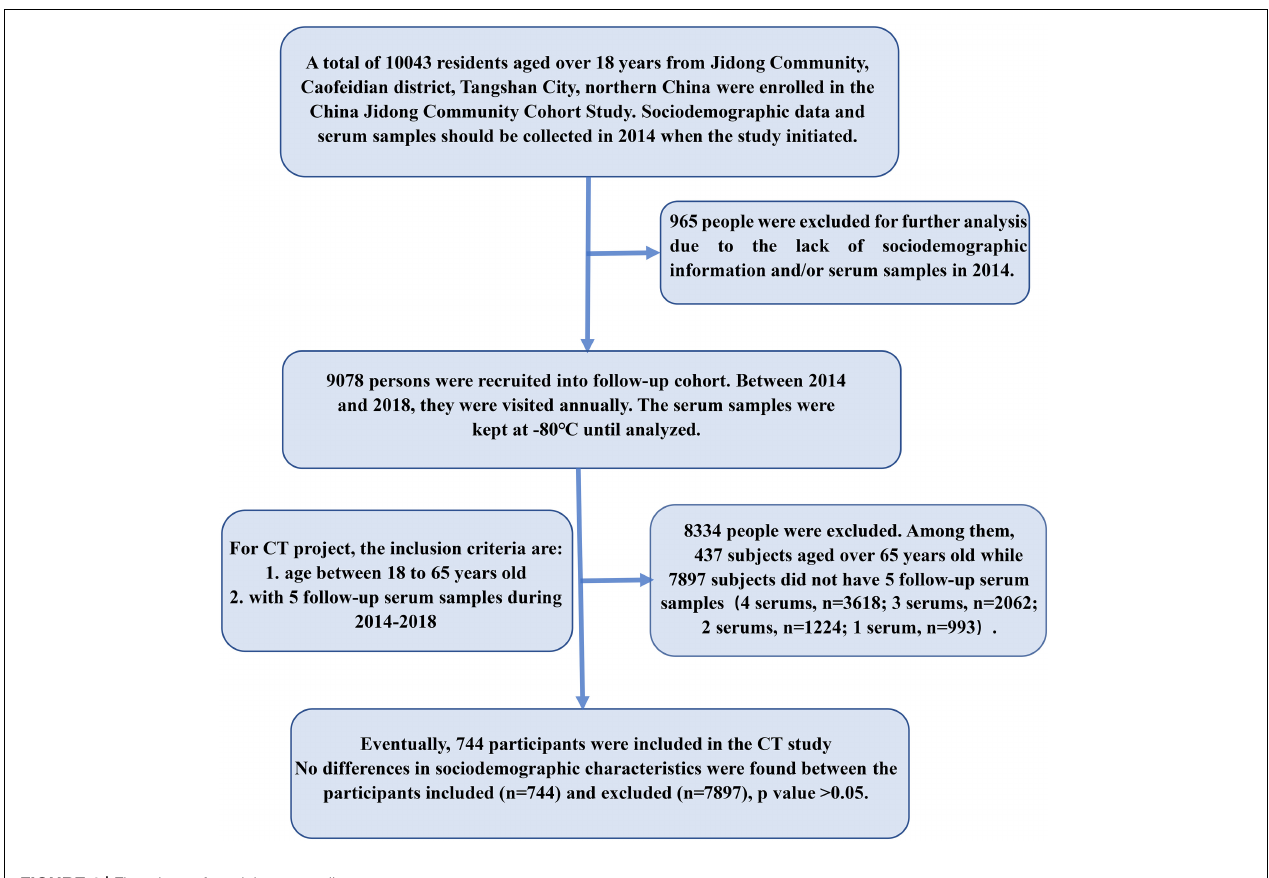
FIGURE 1 | Flowchart of participant enrollment. TABLE 1 | Performance of Pgp3-based LISA and the commercial Mikrogen ELISA when testing C. trachomatis -positive and negative